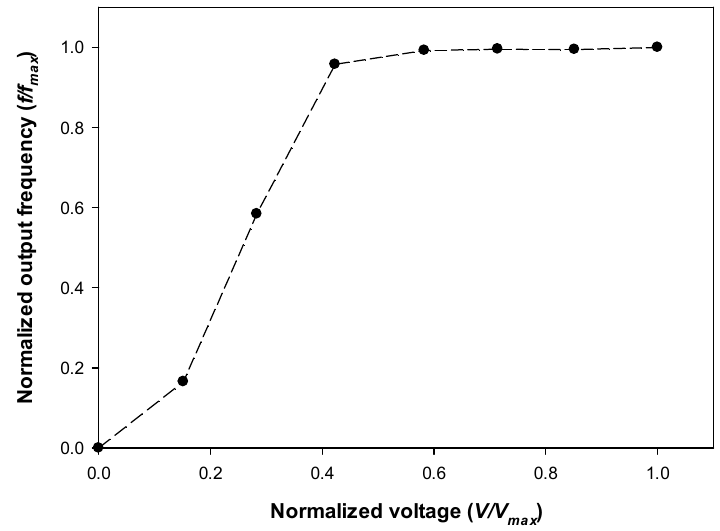
Figure 4. Normalized frequency response of the UVTRON R9454